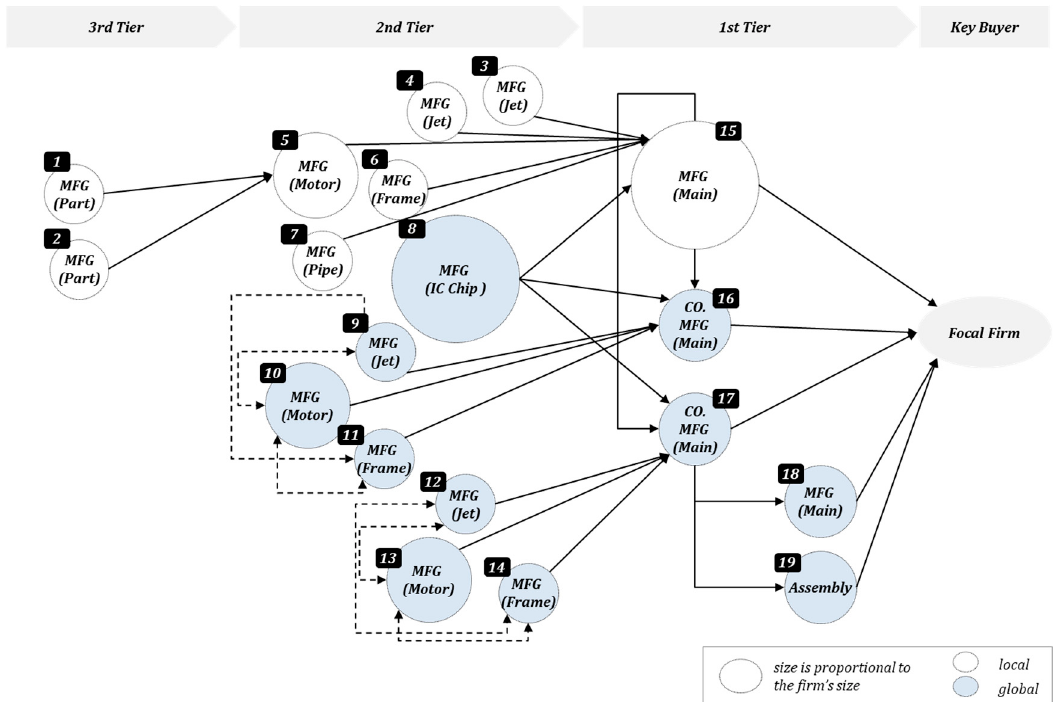
Figure 1. Network structure of the evaluated case.